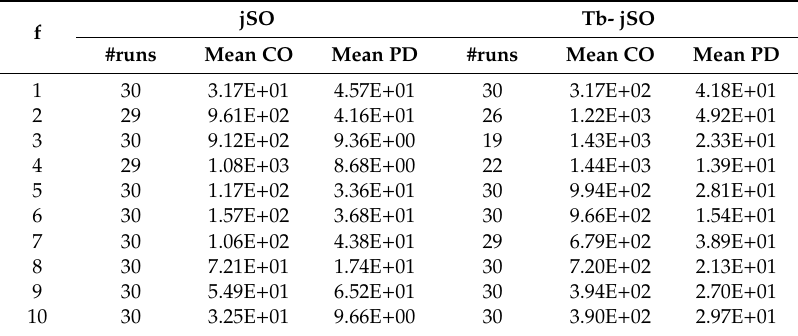
Table 31. Clustering and population diversity of jSO and Tb-jSO on the CEC2020 in 5 D .